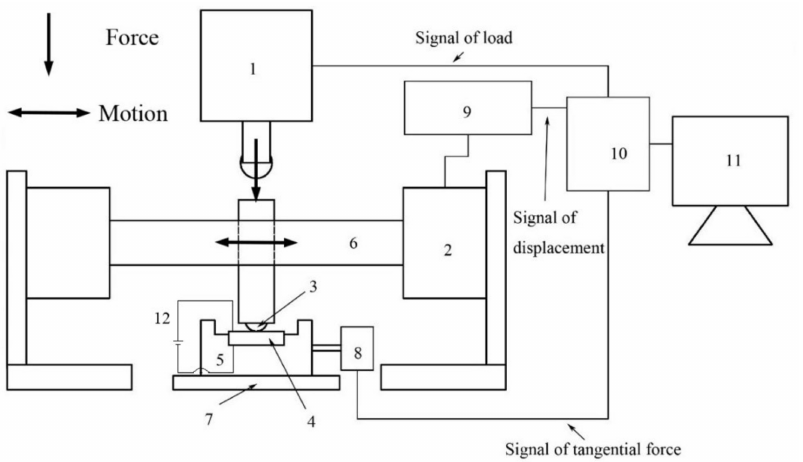
Figure 2. Schematic diagram of fretting wear test setup: 1—pressure sensor, 2—electromagnetic actuator, 3—sphere sample, 4—plate sample, 5—base, 6—connecting rod, 7—screw module, 8—piezo board, 9—voice coil board, 10—control unit, 11—computer, 12—constant voltage